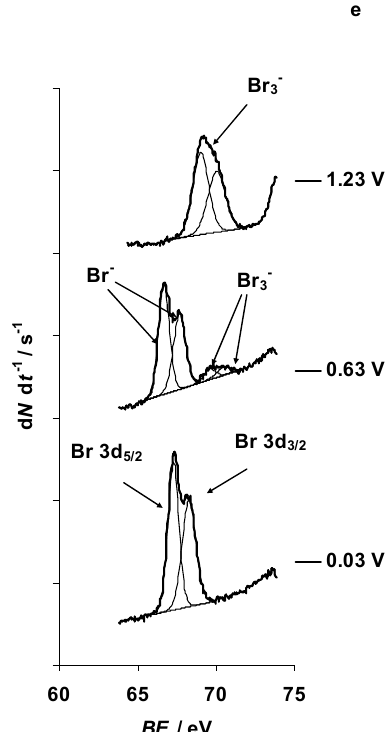
Figure 10. C 1s, N 1s, B 1s, F 1s, and Br 3d X-ray photoelectron (PE) spectra for the 5 wt % EMImBr solution in the EMImBF 4 mixture measured at the fixed positive potentials of the C(Mo 2 C) electrode, noted in the figure. The binding energy ( BE ) scales for the XPS experiments have been referenced to the BE of the C 1s photoemission line related to aliphatic carbon ( BE = 285.3 eV) measured for the non-polarized and grounded electrode: ( a ) C 1s PE spectra, fitted applying the four C 1s photoelectron peak model (regular lines); excitation energy was 400 eV, and the PE signal intensity (d N d t − 1 ) scale between tick marks was 500 counts s − 1 ; ( b ) N 1s PE spectra; excitation energy was 500 eV, and the PE signal intensity scale between tick marks was 200 counts s − 1 ; ( c ) B 1s PE spectra; excitation energy was 250 eV, and the PE signal intensity scale between tick marks was 200 counts s − 1 ; ( d ) F 1s PE spectra; excitation energy was 800 eV, and the PE signal intensity scale between tick marks was 10 counts s − 1 ; ( e ) Br 3d PE spectra; excitation energy was 120 eV, and the PE signal intensity scale between tick marks was 50 counts s − 1 .